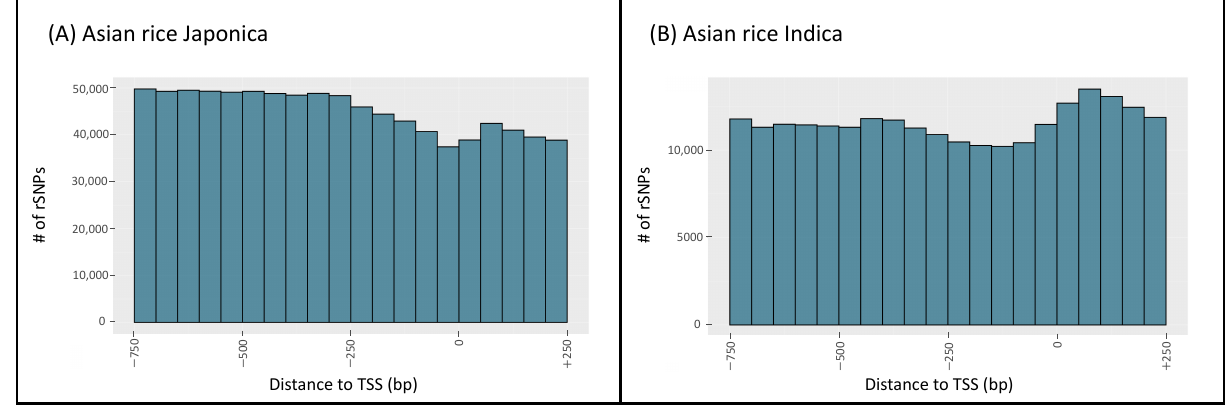
Figure 3. Distribution of the distances between rSNPs and the TSS of ( A ) Asian rice Japonica and ( B ) Asian rice Indica. The histograms show the number of rSNPs in the proximal promoter region ( − 750 bp to +250 bp) in 50 bp